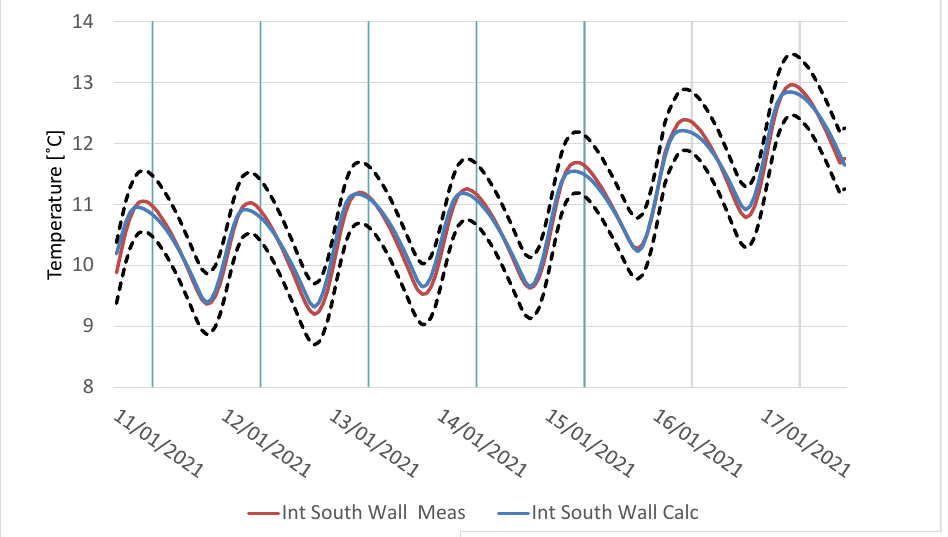
Título del gráfico